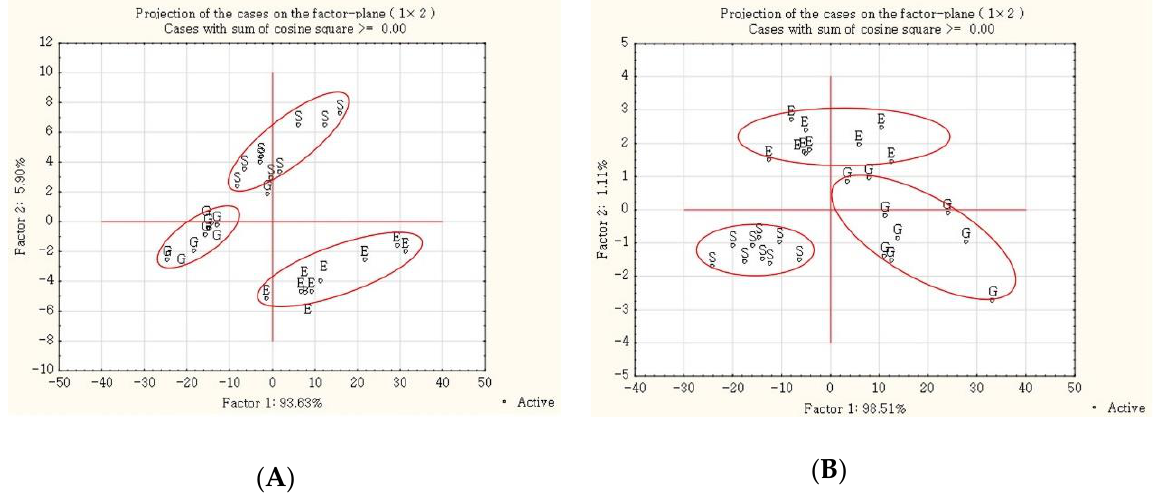
Figure 2. Multivariate analysis of Fourier transformed infrared (FT/IR) spectroscopy spectrum of differently processed corn. Spectra were in the region related ( A ) total carbohydrates, 946 to 1187/cm and ( B ) protein region, 1485 to 1717/cm of ground (G)corn, steam-flaked (S) corn, extruded (E) corn by principal component analysis. Nine spectra for each corn process type were used.